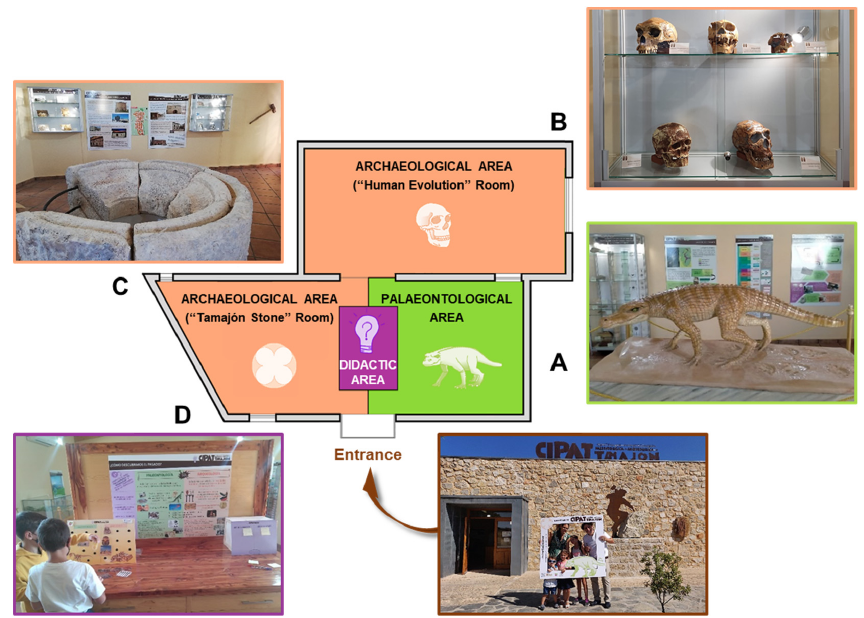
Figure 3. The Palaeontological and Archaeological Interpretation Centre of Tamajón (CIPAT). The map of the CIPAT in the middle, the Palaeontological Area (green, ( A )), the Archaeological Area (orange, with the rooms of “Human Evolution” ( B ) and “Tamajón Stone” ( C ), and the Didactic Area (purple, ( D )), and photographs of the front of the centre (entrance) and of each of the mentioned areas, following the anticlockwise itinerary.